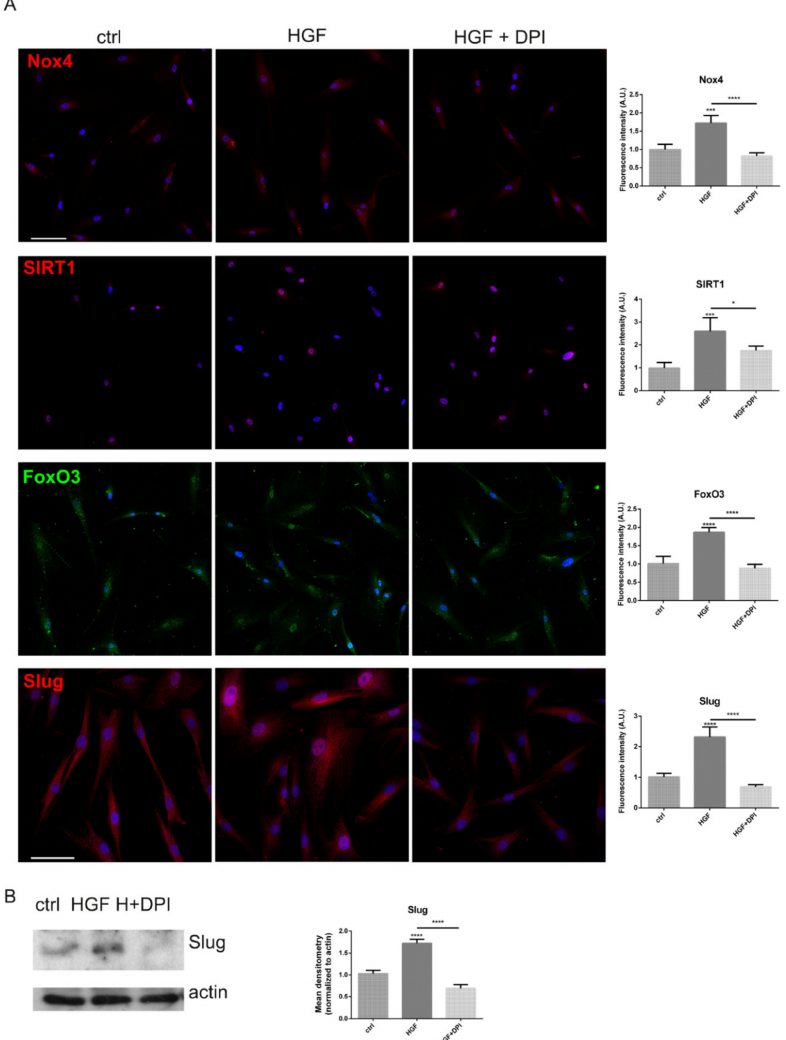
Figure 5. Nox4 and c-met modulation in MeM BRAF mutated primary melanoma cells. ( A ) Representative images with DAPI (blue), FoxO3 (green) or Nox4, SIRT1, Slug (red) signals of BRAF mutated primary cells treated as previously reported. Scale bar = 20 µ m. Fluorescence intensity of cells visualized in 5 fields for each condition are shown in the graphs. * p -value < 0.05, *** p- value < 0.001. ( B ) Western blot analysis of total lysate of MeM BRAF mut primary cells treated or not with DPI in the presence of HGF, then revealed with anti-Slug and anti-actin as a loading control. The graph represents the mean ± SD of densitometric analysis of three experiments, normalized to actin values. **** p- value <